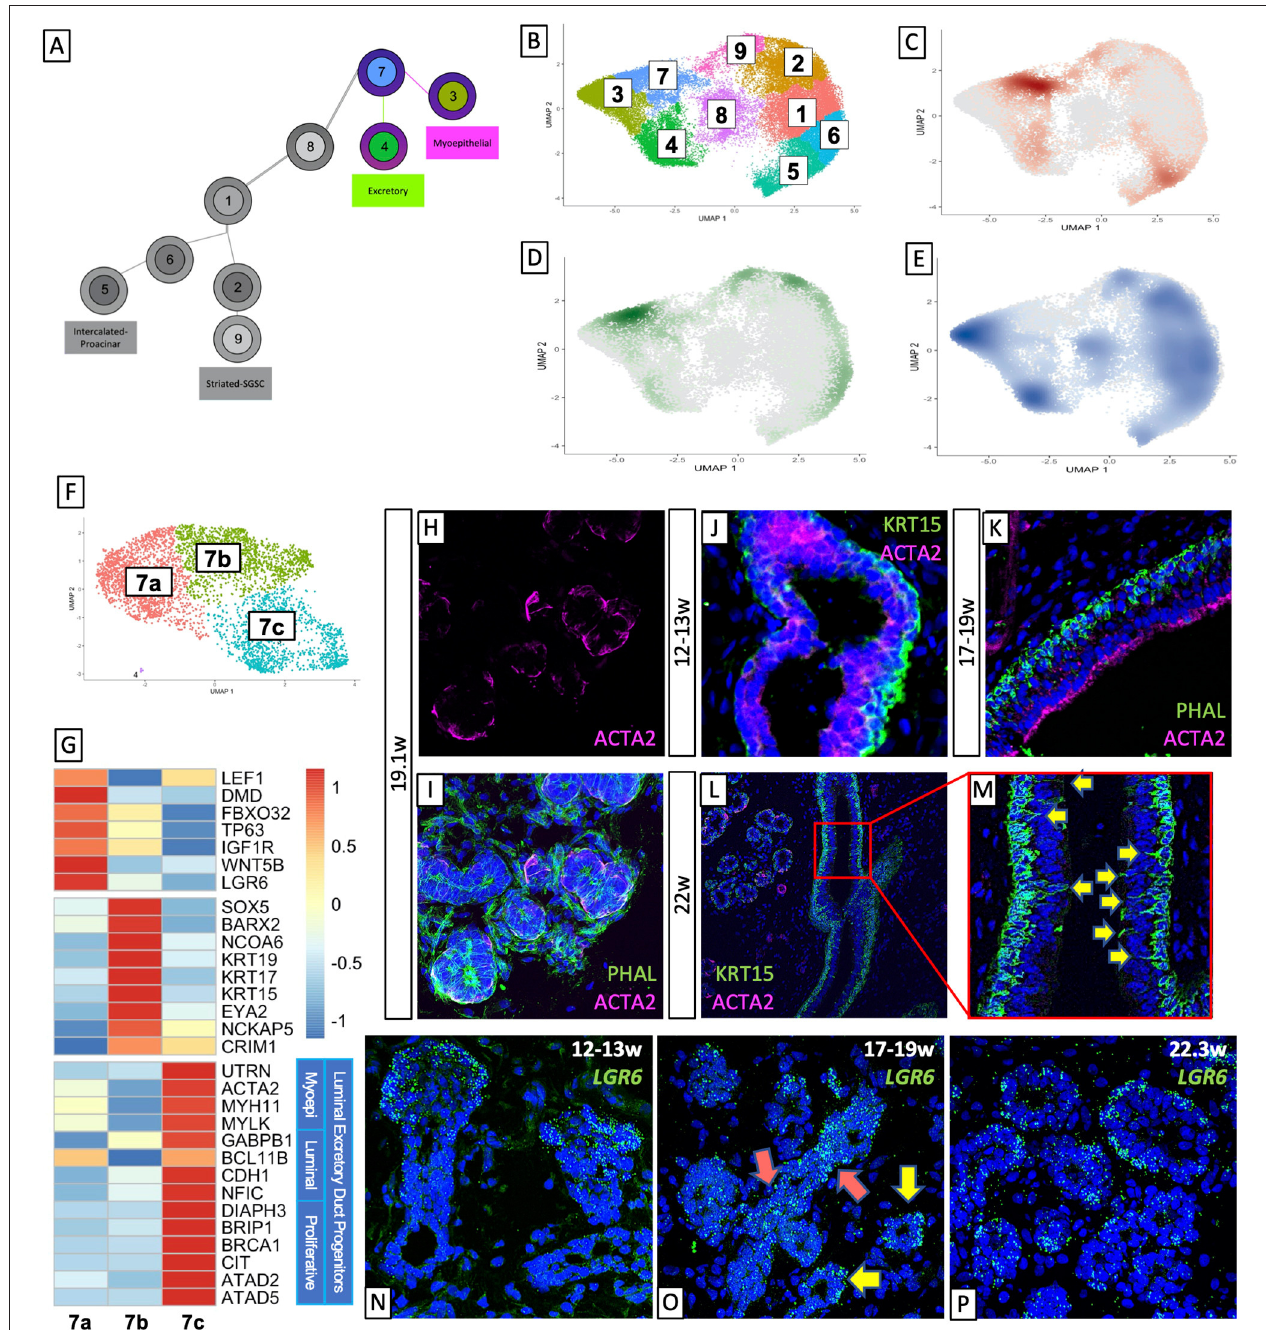
FIGURE 2 | Basal epithelial progenitors give rise to excretory duct and different populations of myoepithelial cells. (A) Early BEPs give rise to Myoepithelial cells and Excretory Duct. Density plotted by age (C–E) in the salivary epithelium (B) showed that early cells are overrepresented in the BEPs and at 12–13 weeks (C) , are moving toward the excretory duct. At 14–16 weeks (D) the bias of cells shifts toward the myoepithelial cluster, and by 17–19 weeks (E) most cells have moved out of BEPs and occupied their respective mature populations. (F) Subsetting BEPs yields 3 clusters. (G) Top gene expression shows a distinct transcriptional expression of each cluster, with 7a expressing myoepithelial progenitor markers, 7b expressing basal duct markers, and 7c expressing groups of genes with distinct functional associations. (H,I) Human fetal tissue at 19.1w shows an expression of ACTA2 surrounding traditional ductal types. (J,K) Human fetal excretory duct at 12–13w (J) and 17–19w (K) show basal expression of KRT15 and luminal expression of ACTA2. (L) Human fetal salivary glands at 22w only exhibit ACTA2 expression around intercalated/straited duct types, but not lining the luminal excretory duct expression of ACTA2. (M) KRT15 in the basal excretory duct shows that basal duct cells exhibit membrane protrusions toward the luminal side. (N–P) LGR6 expression at 12–13w (N) and 17–19w (O) show the presence of BEPs in non-lumenized ducts. 17–19w and 22.3w (P) samples show expression of LGR6 around the outer edge of lumenized ducts, in line with myoepithelial cell localization.